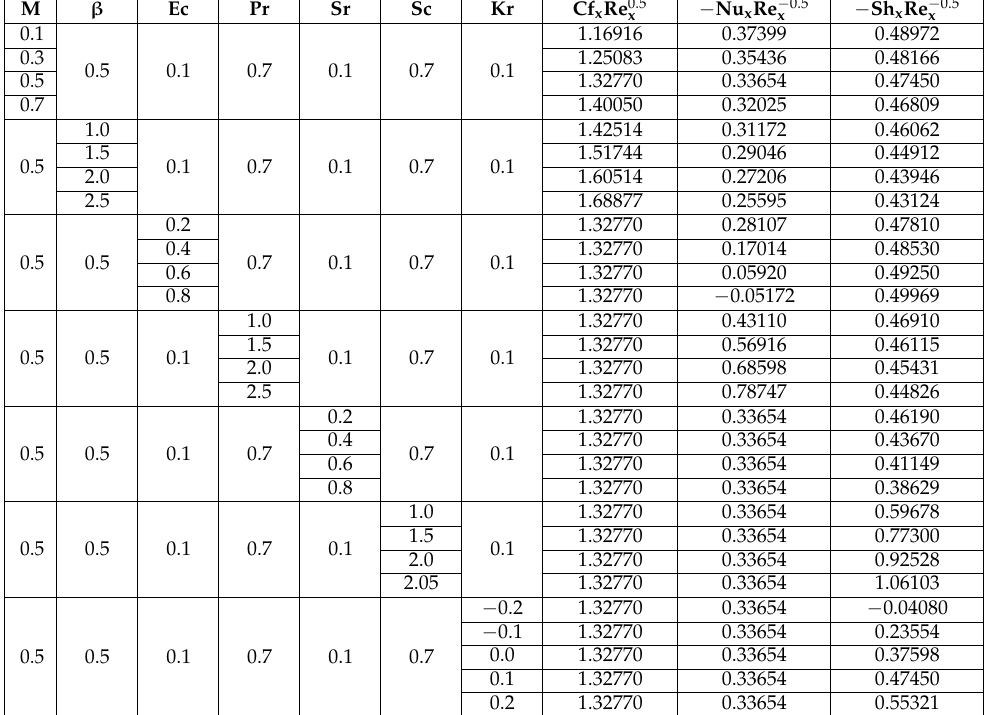
Table 2. Impact of physical parameters on engineering quantities of interest.